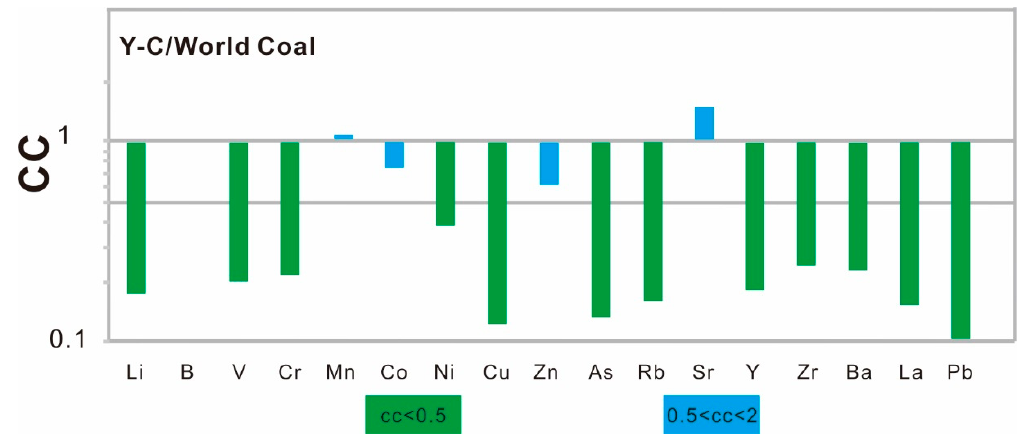
Figure 2. Concentration coefficients of trace elements in feed coal from Yihua power plant normalized to average values in Chinese [50] and worldwide [51] coals (modified after Dai et al., 2015) [29].